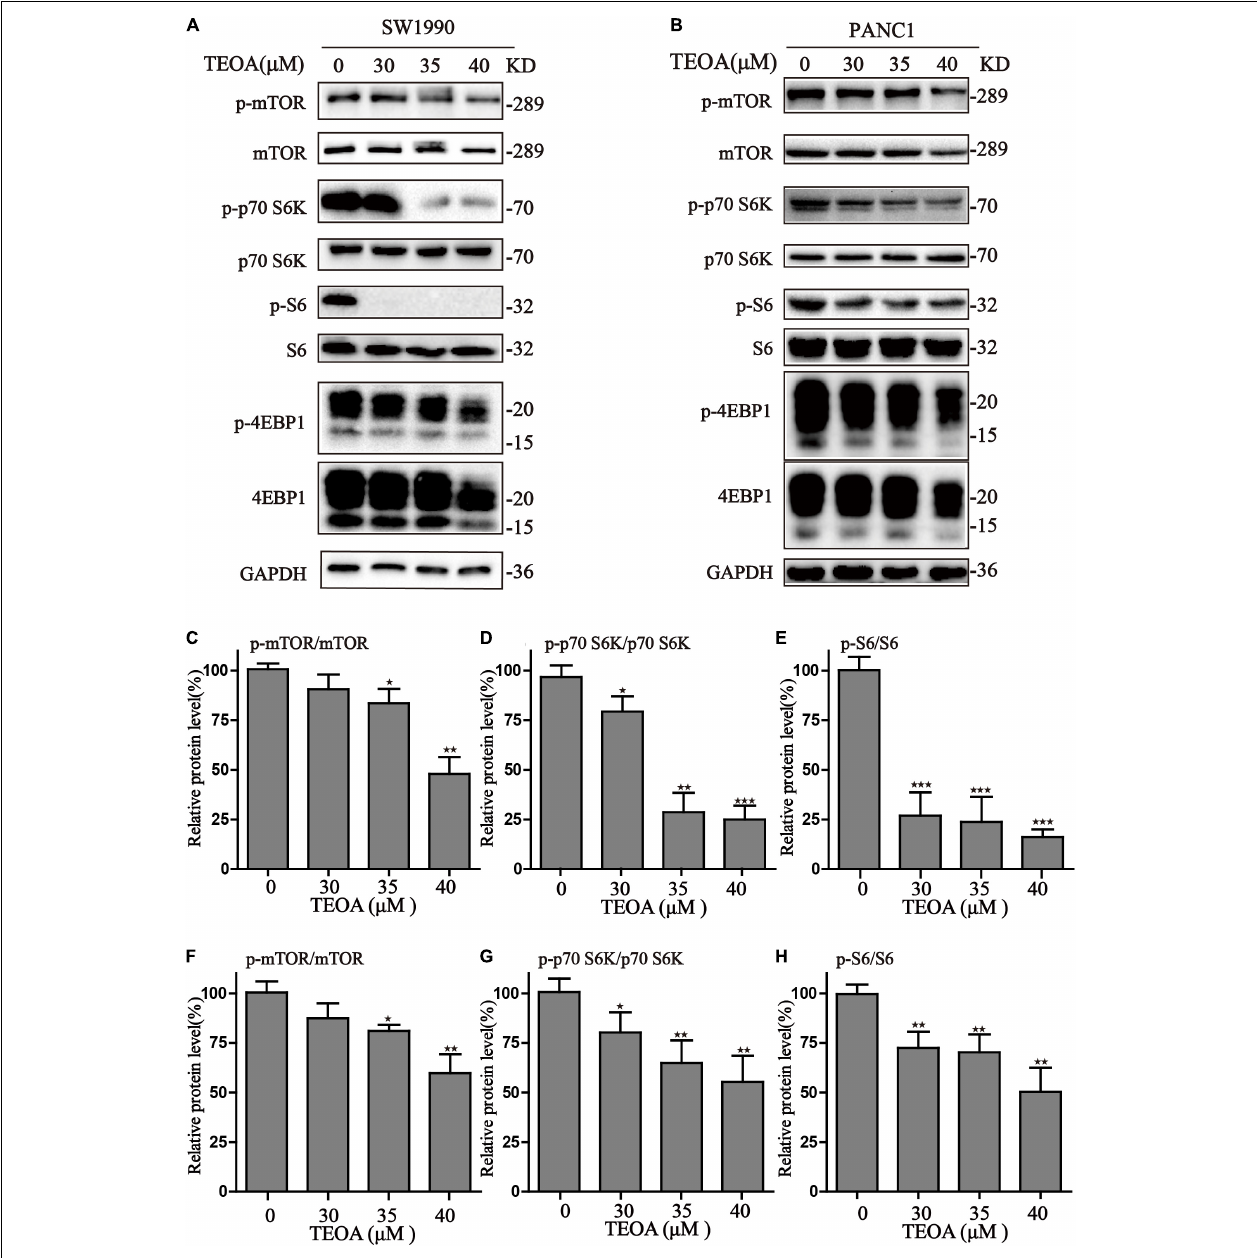
FIGURE 6 | TEOA induced autophagy via inhibiting mTOR/p70s6k/S6 signaling pathway in pancreatic cancer cells. (A,B) After exposure to TEOA for 8 h, SW1990 and PANC1 cells were collected to measure the signaling pathway of mTOR/p70s6k/S6, GAPDH used as a loading control. (C–E) Relative quantitative analysis of SW1990 was shown. (F–H) Relative quantitative analysis of PANC1 was shown ( (cid:70) p < 0.05; (cid:70)(cid:70) p < 0.01; (cid:70)(cid:70)(cid:70) p < 0.001, versus